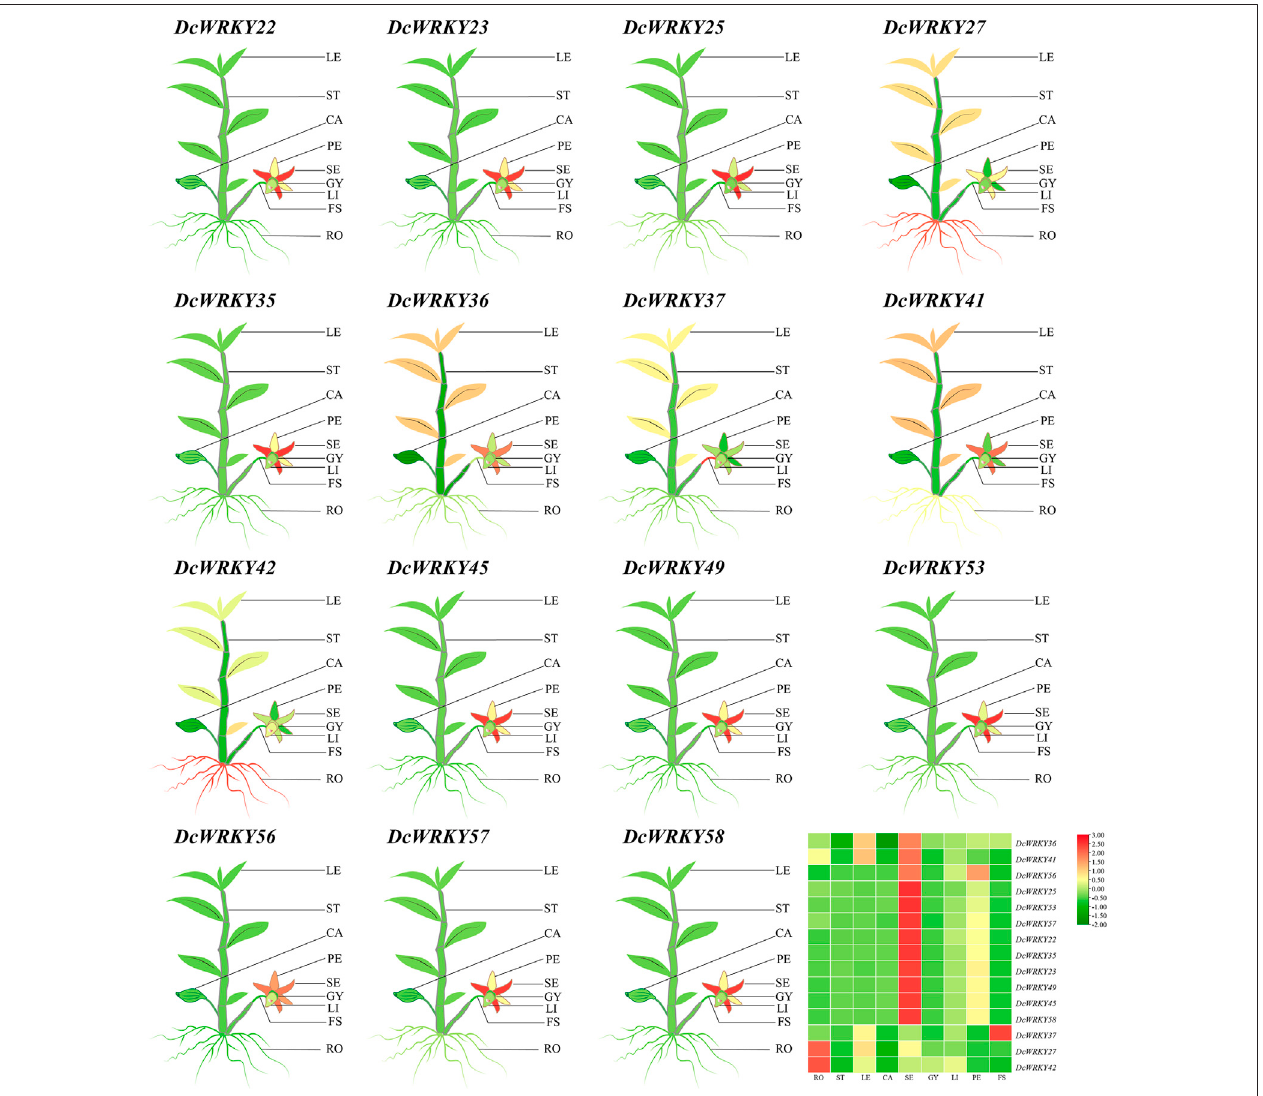
FIGURE 7 | Tissue-speci fi c expression of representative DcWRKY genes by RT-qPCR. The mean expression value was calculated from three independent biological replicates relative to that in roots. The mean expression values were visualized by TBtools; red and green represent high and low expression levels, respectively. The relative expression values areprovided in Supplementary Table S8 .LE, leaf; ST, stem; CA, capsule; PE:petal;SE, sepal; GY, gynostemia;LI, lip; FS, fl ower stalk; RO, root.